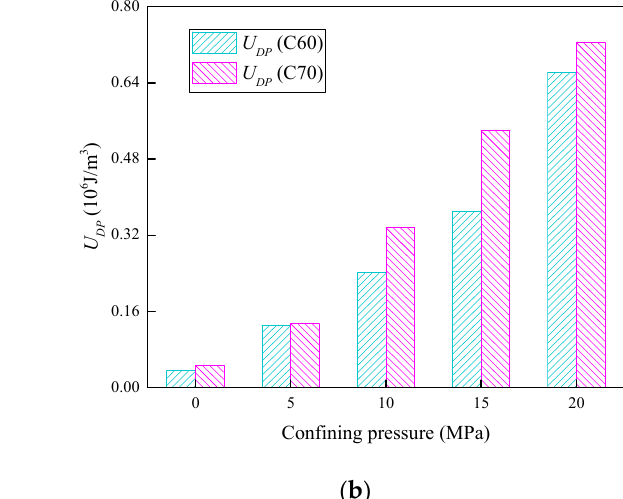
U and U . ( a ) Relationship between FP DP